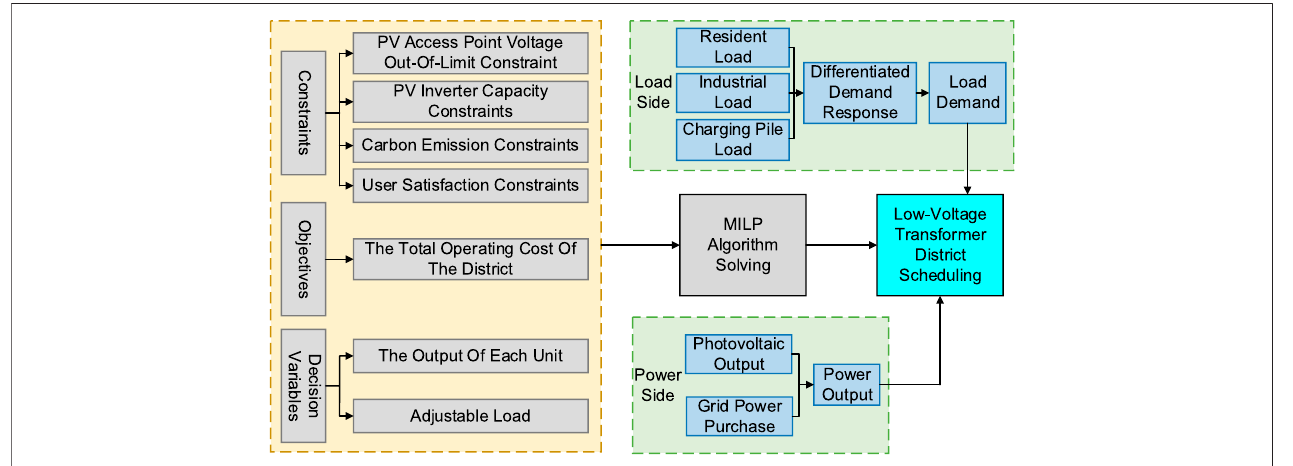
FIGURE 2 | Scheduling framework of the low-voltage transformer district considering carbon emissions and differential demand response.